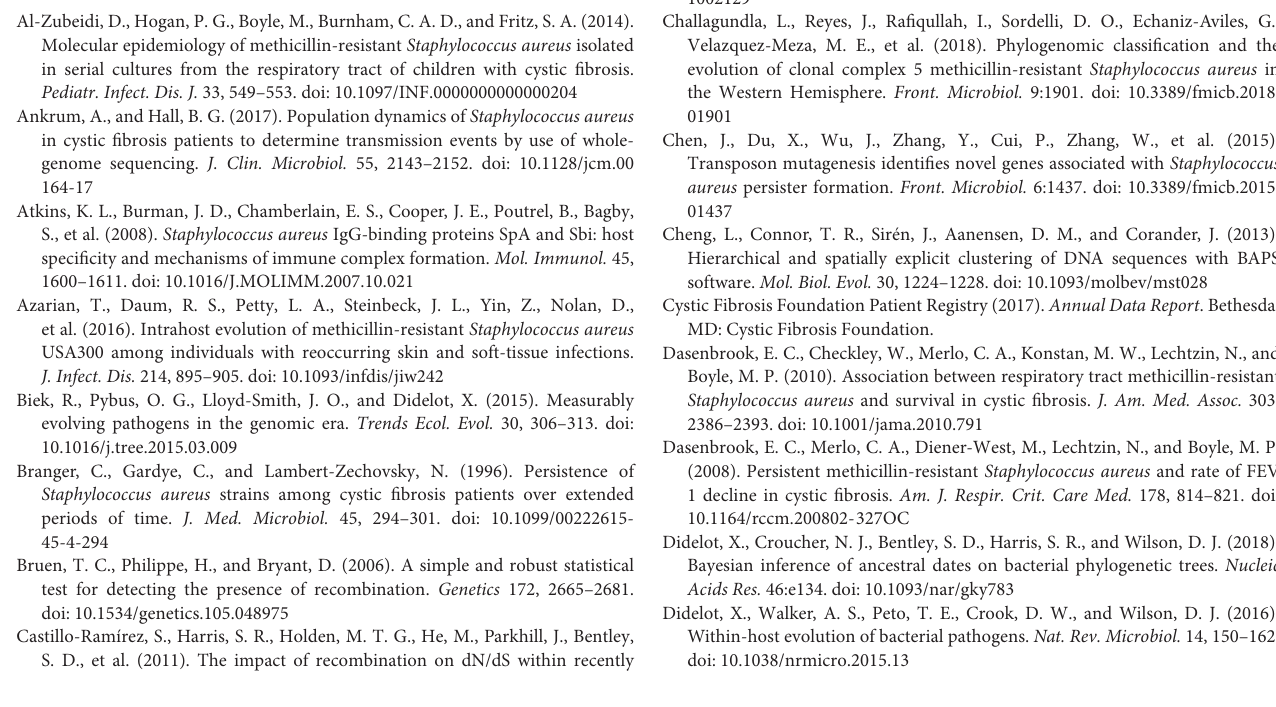
FIGURE S1 | (A) Distribution of days separating pairs of sampled isolates stratified into seven categories; (B) Pairwise SNP distances stratified by categorized